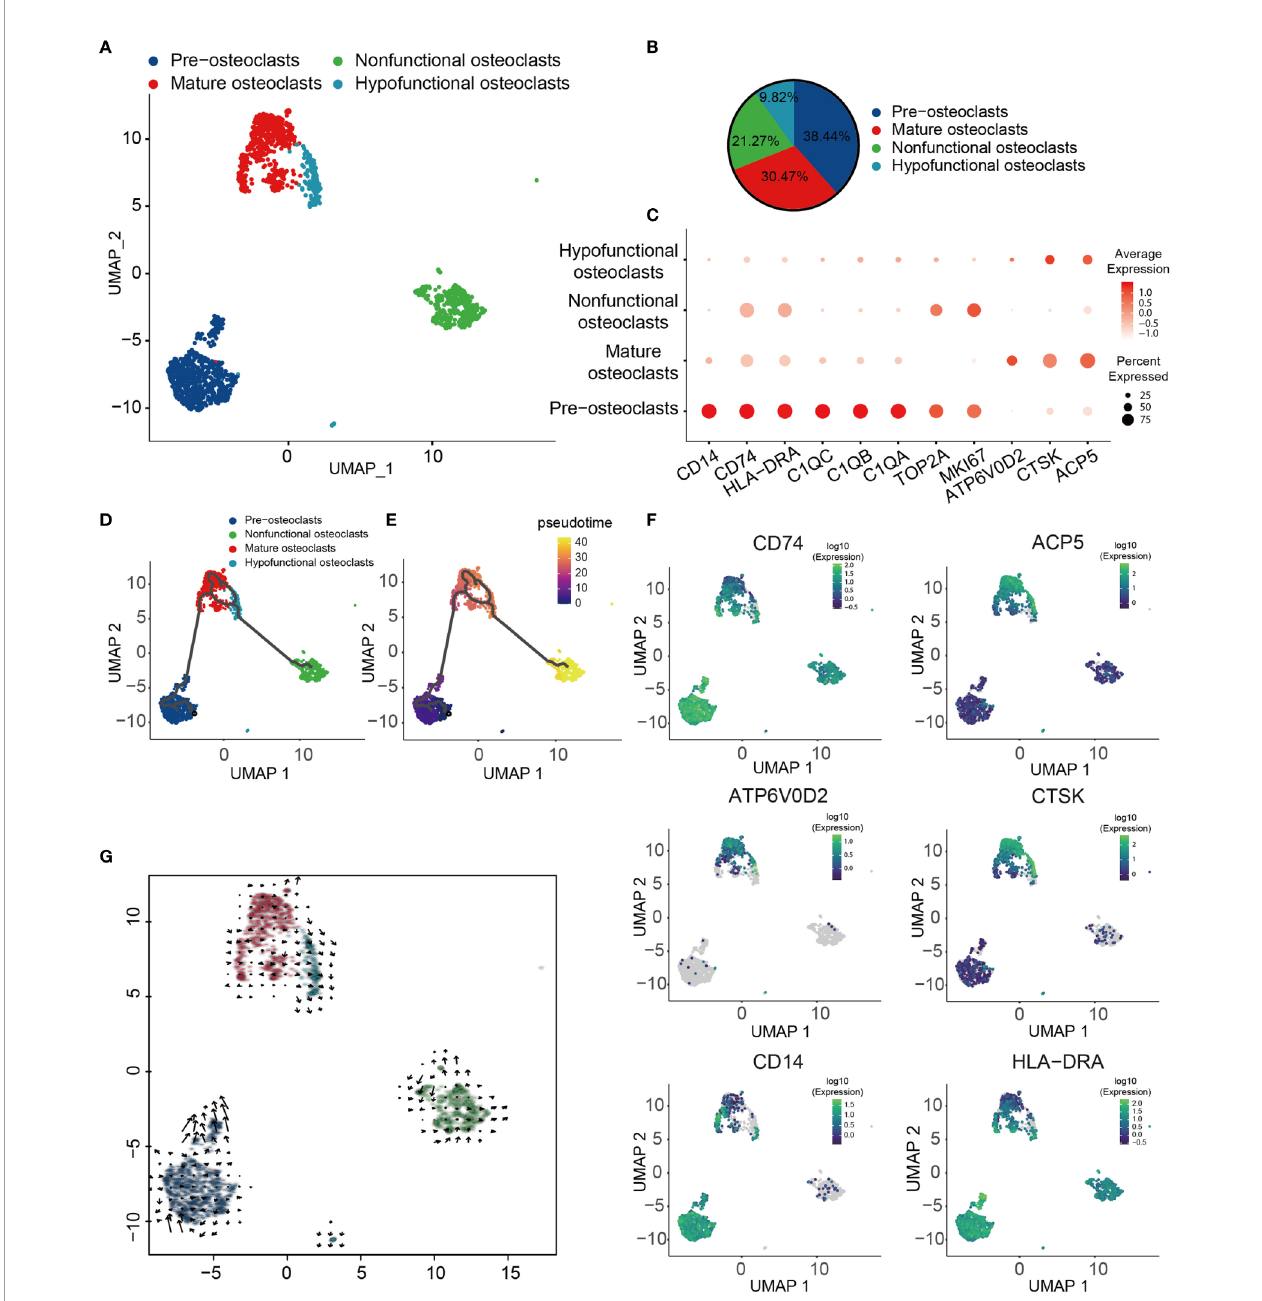
FIGURE 3 | Heterogeneity of OC populations in human OS. (A) UMAP plot showing OCs, with different cell types represented by different colors. (B) Pie chart, indicating the cell composition of OC. (C) Dot-plot of marker genes in each cell subtype; shades of red represent the expression level, and dot sizes represent relative abundance. (D, E) Differentiation and developmental trajectories of OCs in OS, with different colors representing different cell subtypes. (F) Differentiation and developmental trajectories using marker gene expression (CD74, ACP5, ATP6V0D2, CTSK, CD14 and HLA-DRA). (G) RNA velocity fi eld projected onto the UMAP plot of the OC; arrows indicate the direction of differentiation and the average velocity. OC, osteoclast; OS, osteosarcoma; UMAP, uniform manifold approximation and